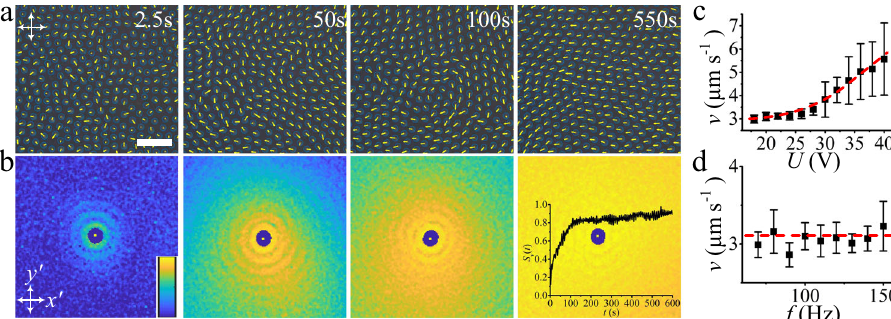
Fig. 6 Temporal evolution of directron velocities and their dependence on electric fi elds. a Polarizing micrographs of directrons at U = 20 V, f = 100 Hz, with their velocities represented as yellow arrows. Scale bar 50 μ m. The crossed polarizers are indicated as white arrows. The time after the application of the electric fi eld is indicated in each image. b 2D spatial velocity correlation functions corresponding to a colored according to the color bar which changes linearly from 0 (dark blue) to 1 (light yellow). Image sizes represent an area of 200 μ m × 200 μ m. The inset shows the temporal evolution of the velocity order parameter, S v ( t ). The 2D spatial velocity correlation functions are averaged over 5 s (10 frames). c The dependence of directron velocity on voltage at fi xed frequency ( f = 100 Hz). d The dependence of directron velocity on frequency at fi xed voltage ( U = 20 V). The error bars are calculated from the standard deviation of velocities of hundreds of different directrons.